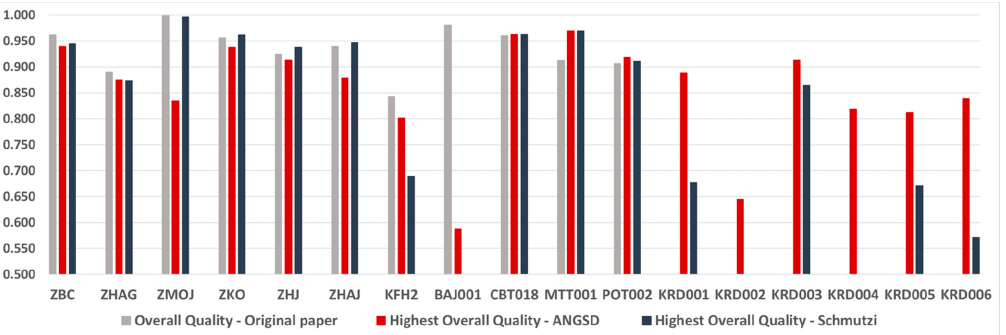
Figure 2. Highest haplogroup prediction accuracy for all samples using mitogenome consensus sequence extracted from raw genomic data by two alternative tools and pipelines (ANGSD vs. schmutzi). Absence of a bar for one of the two tools indicates that either there was a wrong haplogroup perdition or that no consensus sequence could be derived. Absence of a bar for the original paper indicates that no haplogroup was predicted in the original study due to the poor sequence quality.